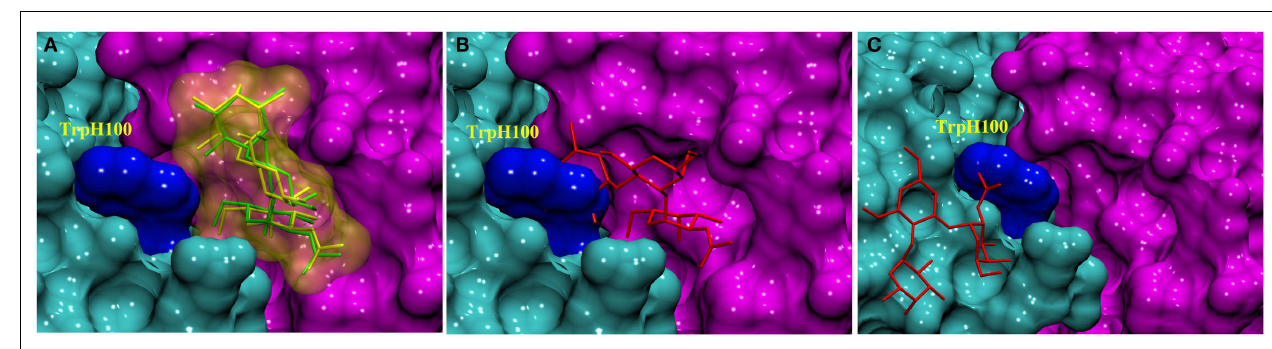
residue docking approaches, respectively. (B) An example of a docked pose (red) that was eliminated on the basis of clashes ensuing from the Ala H100 Trp mutation. (C) An example of a docked pose (red) that was eliminated on the basis of the orientation of the ligand in the binding pocket.